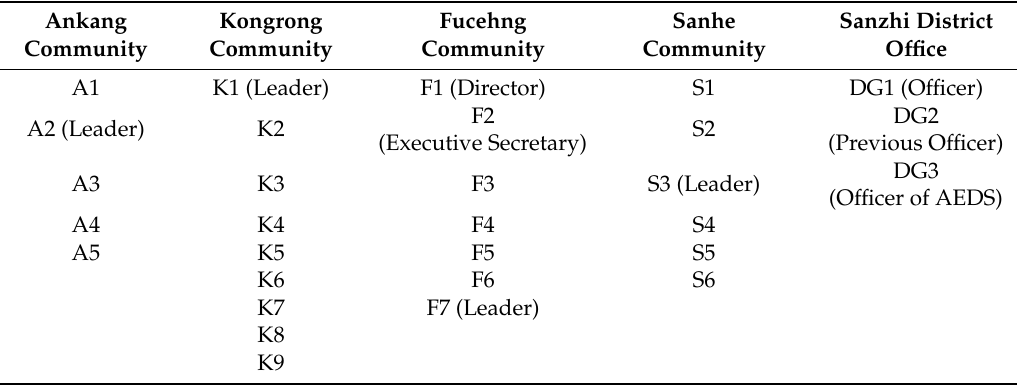
Table 3. LINE group actor